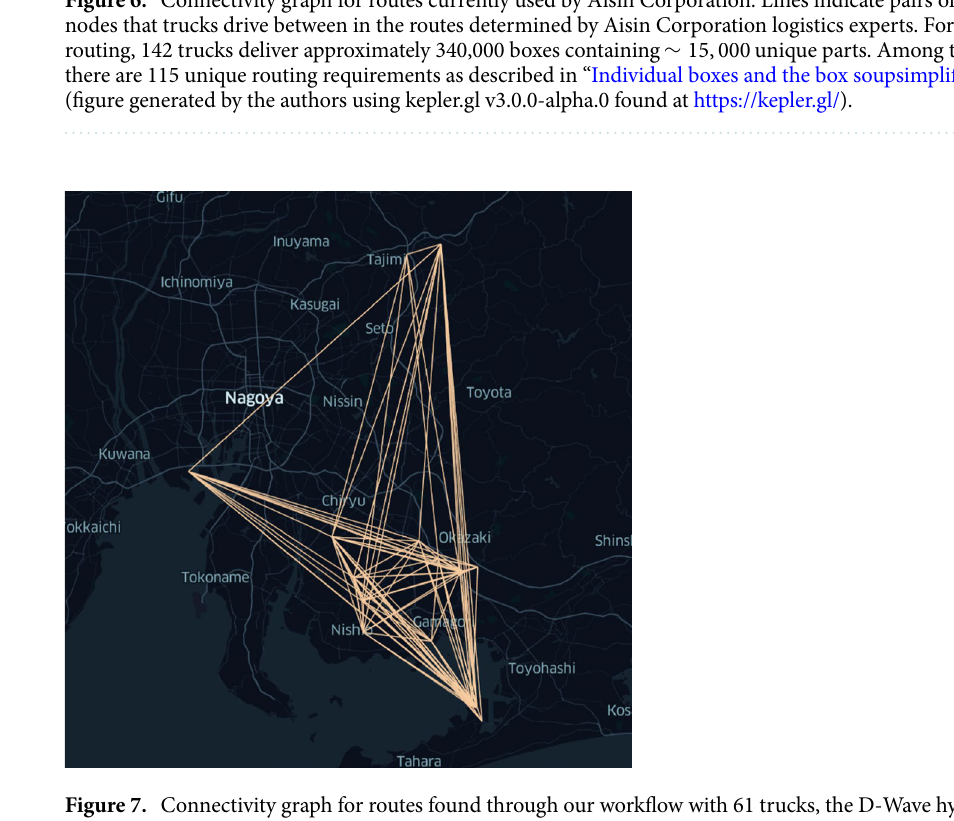
Figure 7. Connectivity graph for routes found through our workflow with 61 trucks, the D-Wave hybrid solver, and full-scale simulation (see “Full-scale simulation”). The problem instance is the same as described in the caption of Fig. 6 (figure generated by the authors using kepler.gl v3.0.0-alpha.0 found at https:// kepler.